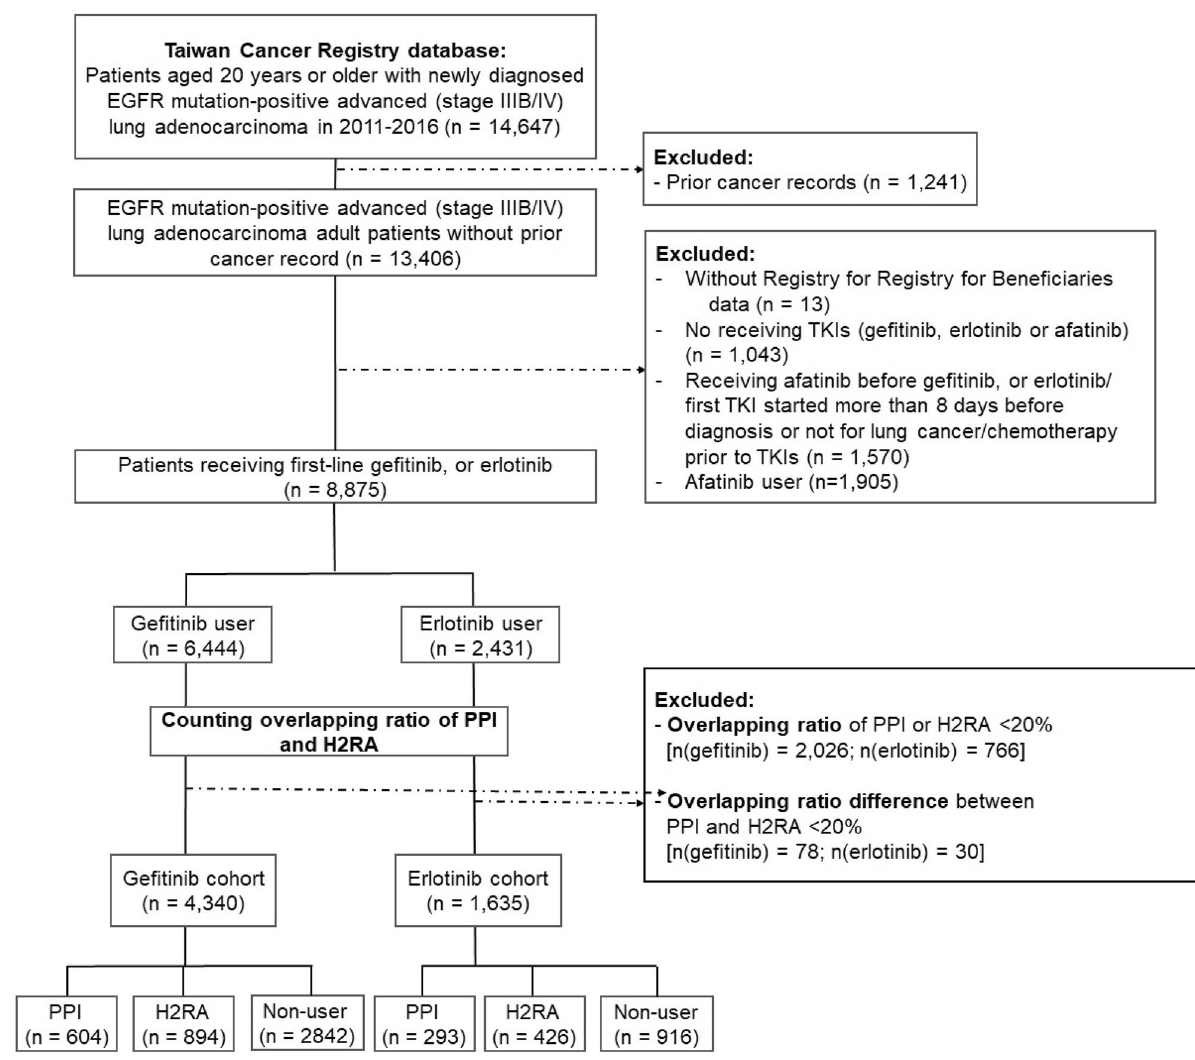
Figure 1. Flow chart of the study